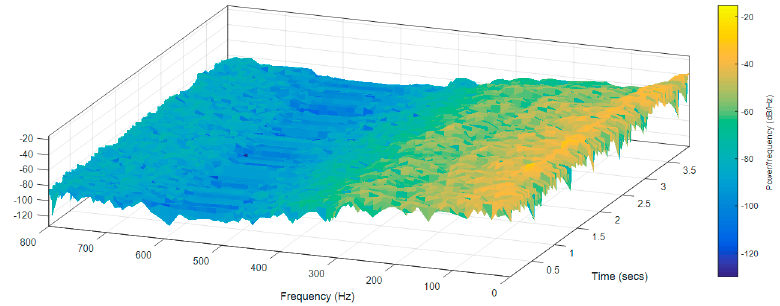
Figure 13. Frequency spectra of the accelerations measured over the longitudinal axis at the head of the APR-2 prototype (with passive suspension).